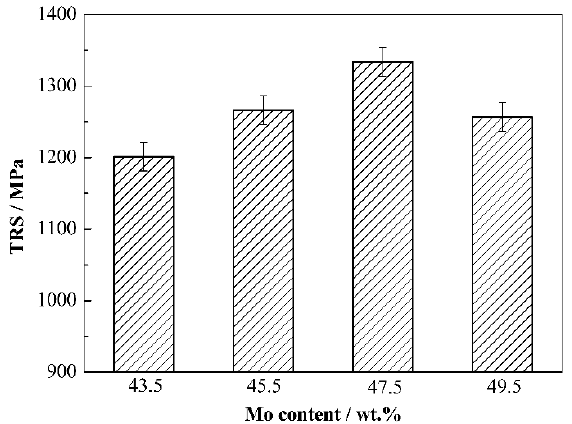
Figure 11. TRS of Mo 2 FeB 2 based cermets with different Mo contents.